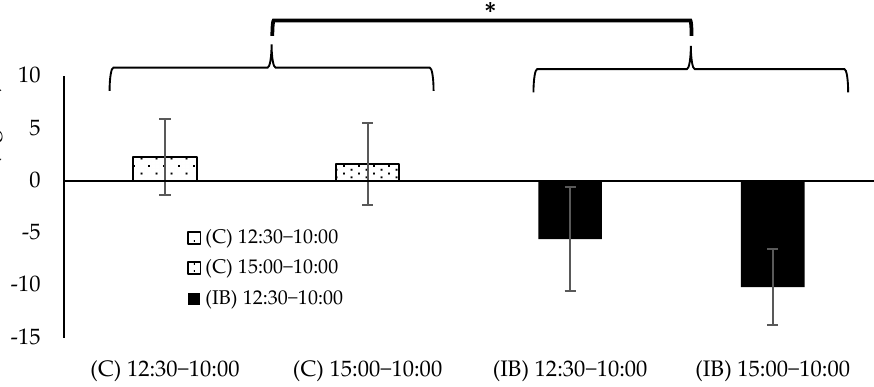
Figure 6. Values are expressed as mean ± SE; ∆ plasma cortisol. Significant differences between C and IB at same time point are represented by asterisk (* p < 0.05). 3.3. Correlation between Skin Surface Temperatures of the Three Sites of Horse’s Body (Front Back, Rear Back, Loin) and three Measurement Parameters (HR, RR and Plasma Cortisol) Correlation between skin surface temperatures of the three sites of horse’s body (front back, rear back, loin) and three measurement parameters (HR, RR, and plasma cortisol) are shown in Table 9. The front back and HR of both groups were significantly correlated (R = 0.237, p = 0.011). The front back and HR of the C group only were not significantly correlated. The front back and HR of the IB group only was significantly correlated (R = 0.390, p = 0.0030). The other correlation results were similar with the correlation result between front back and HR.